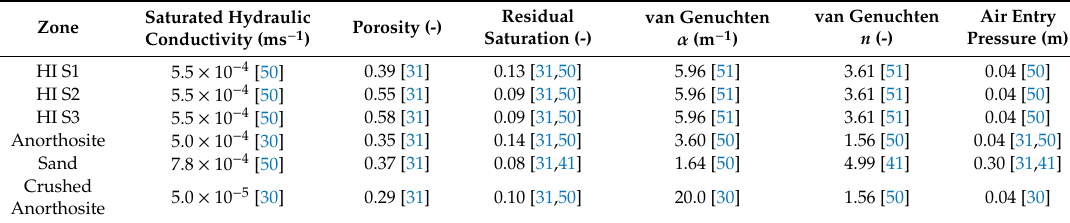
Table 1. Physical parameters for a variably saturated flow separated by